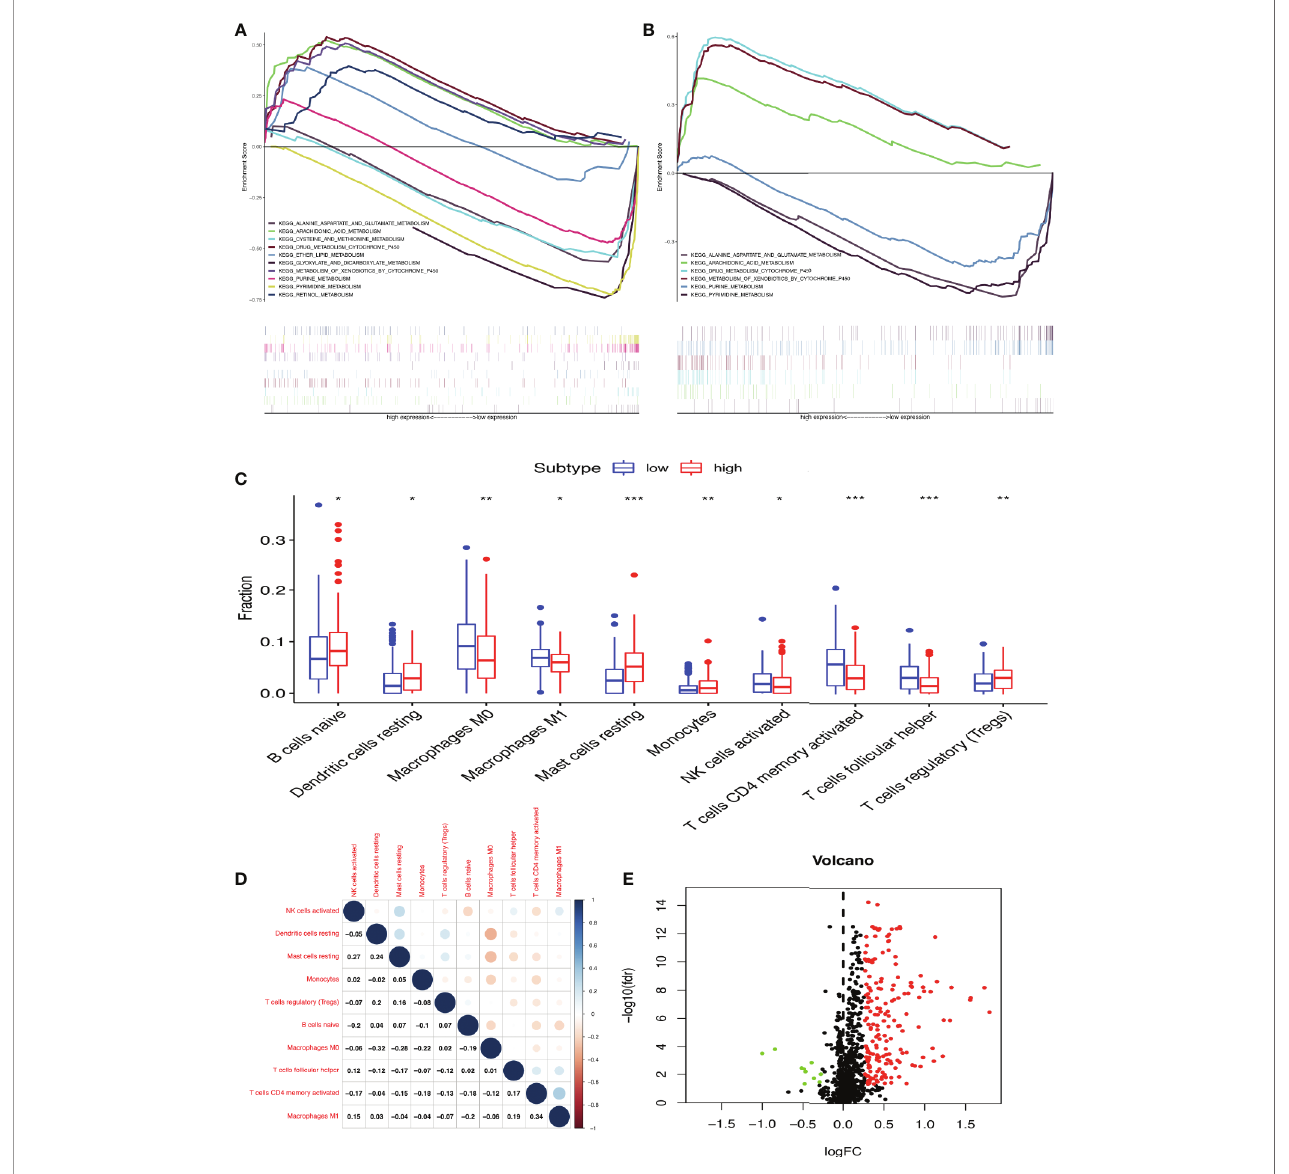
FIGURE 7 | Differentially expressed immune-related genes (DEIRGs) based on Molecular Signatures Database (GSEA) data and different immune responses between high- and low-risk score groups in stomach adenocarcinoma (STAD). (A) DEIRGs between high- and low-risk score groups based on The Cancer Genome Atlas (TCGA) data. (B) DEIRGs between high- and low-risk score groups based on Gene Expression Omnibus (GEO) data. (C) The differential distribution of immune cells between high- and low-risk score groups. (D) The correlation between 10 types of immune cells in STAD. (E) Volcano plot of DEIRGs in STAD between high- and low-risk score groups. Upregulated DEIRGs are shown as red points, and downregulated DEIRGs are shown as green points. *p < 0.05, **p < 0.01, and ***p <